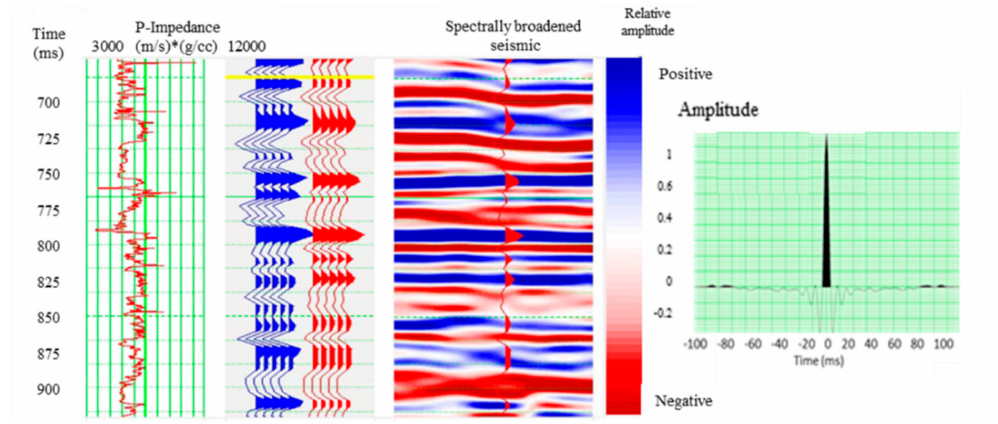
Figure 3. Well-tie to spectrally broadened data; the correlation coefficient is 0.75. Red trace: composite seismic trace. Blue trace: synthetic trace. The right side shows the statistical wavelet used. Polarity: an increase in amplitude corresponds to an increase in acoustic